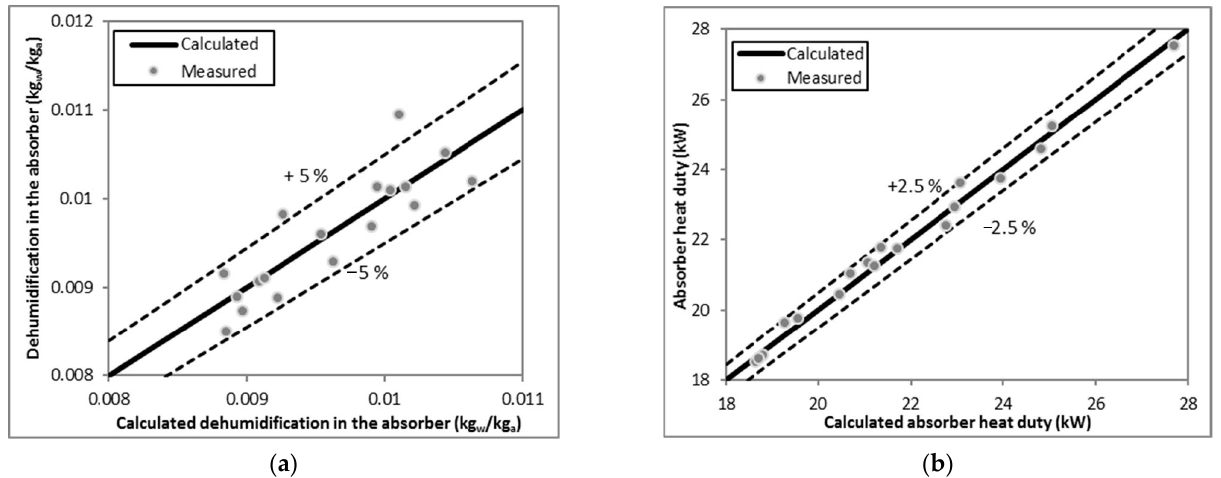
Figure 3. Calculated and measured dehumidification ( a ) and absorber heat duty ( b ).